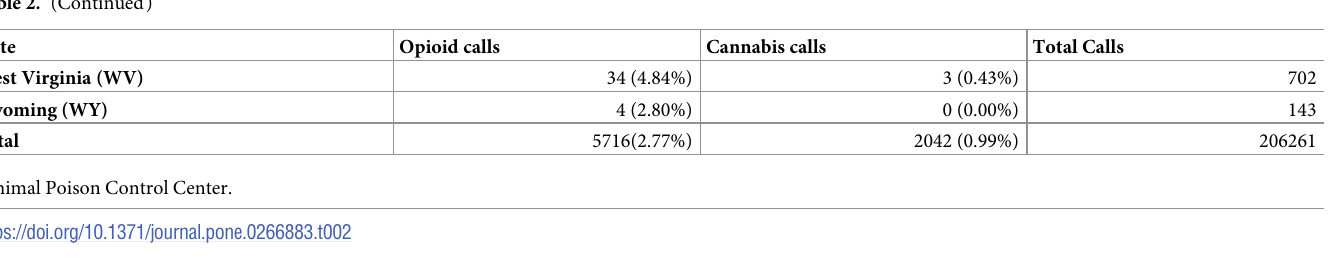
of the east coast of the US. The space-time Bernoulli model and the space-time permutation model both identified 1 space-time cluster of proportionally high opioid calls (Fig 4 & Table 5). The space-time Bernoulli model identified cluster OST1 (Opioid Space-Time 1), which covered southwest Philadelphia in the center of Delaware county, Pennsylvania, and occurred from February 1 to May 31, 2007 (Fig 4 & Table 5). The space-time permutation model identified cluster OST2, which covered northern Delaware, southern Pennsylvania, eastern Maryland, and parts of southwestern New Jersey, and occurred from September 1 to September 30, 2008 (Fig 4 & Table 5). When the analysis was performed on the entire study